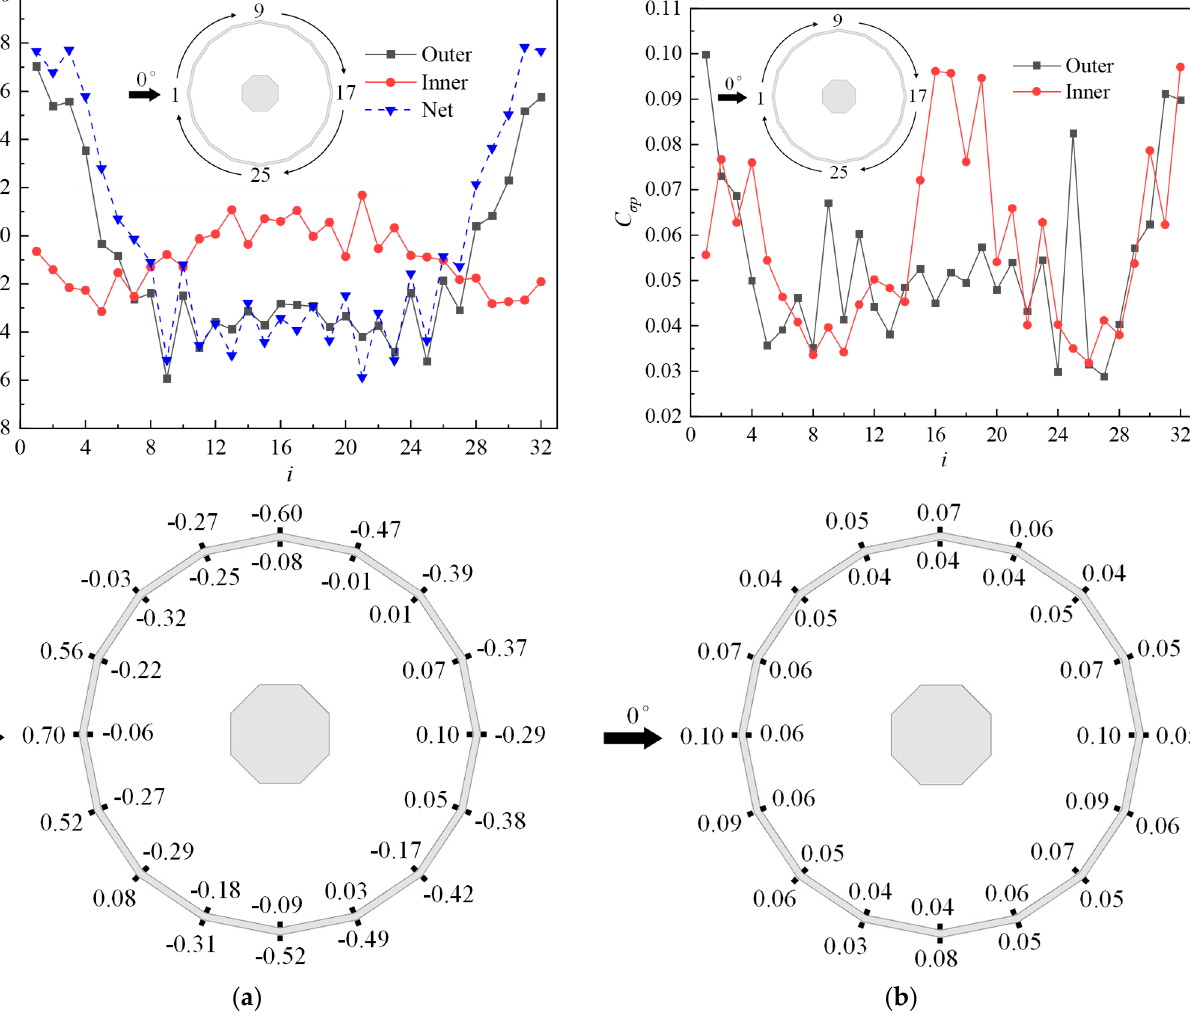
Figure 30. Wind pressure coefficients on the inner and outer surface of the grid structure on the 50 m layer at a 0° wind direction angle: ( a ) Mean wind pressure coefficients at the inner and outer measuring points; ( b ) Fluctuating wind pressure coefficients at the inner and outer measuring points.